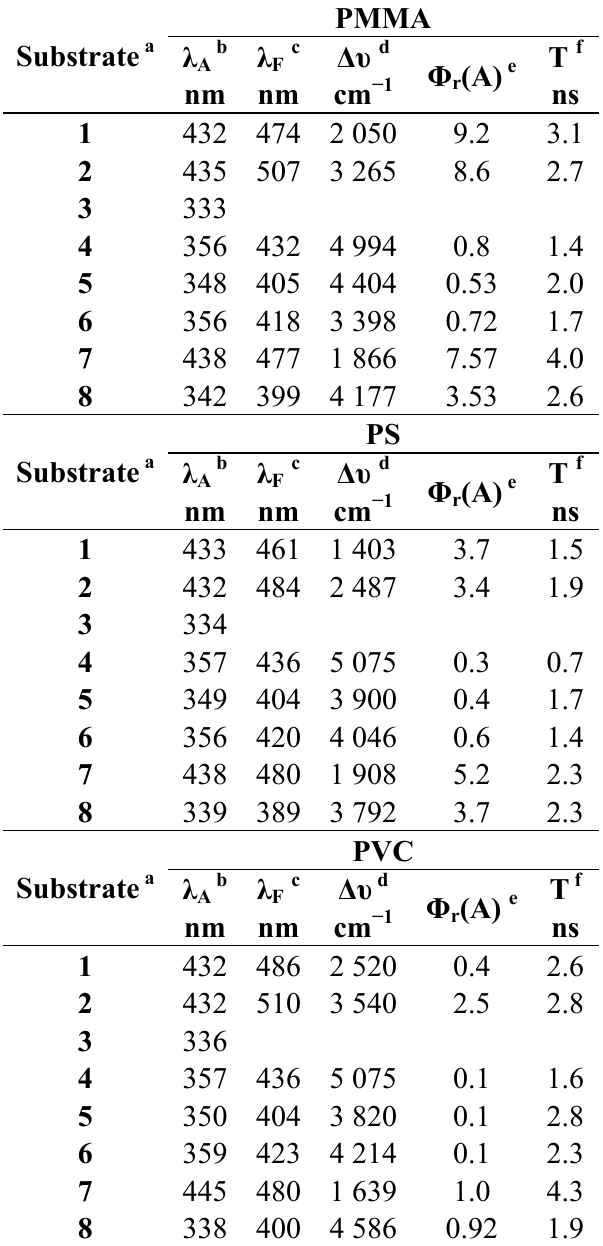
Table 2. Absorption and emission spectra of coumarins 1 - 8 in poly(methylmethacrylate) (PMMA), polystyrene (PS) and poly(vinylchloride)